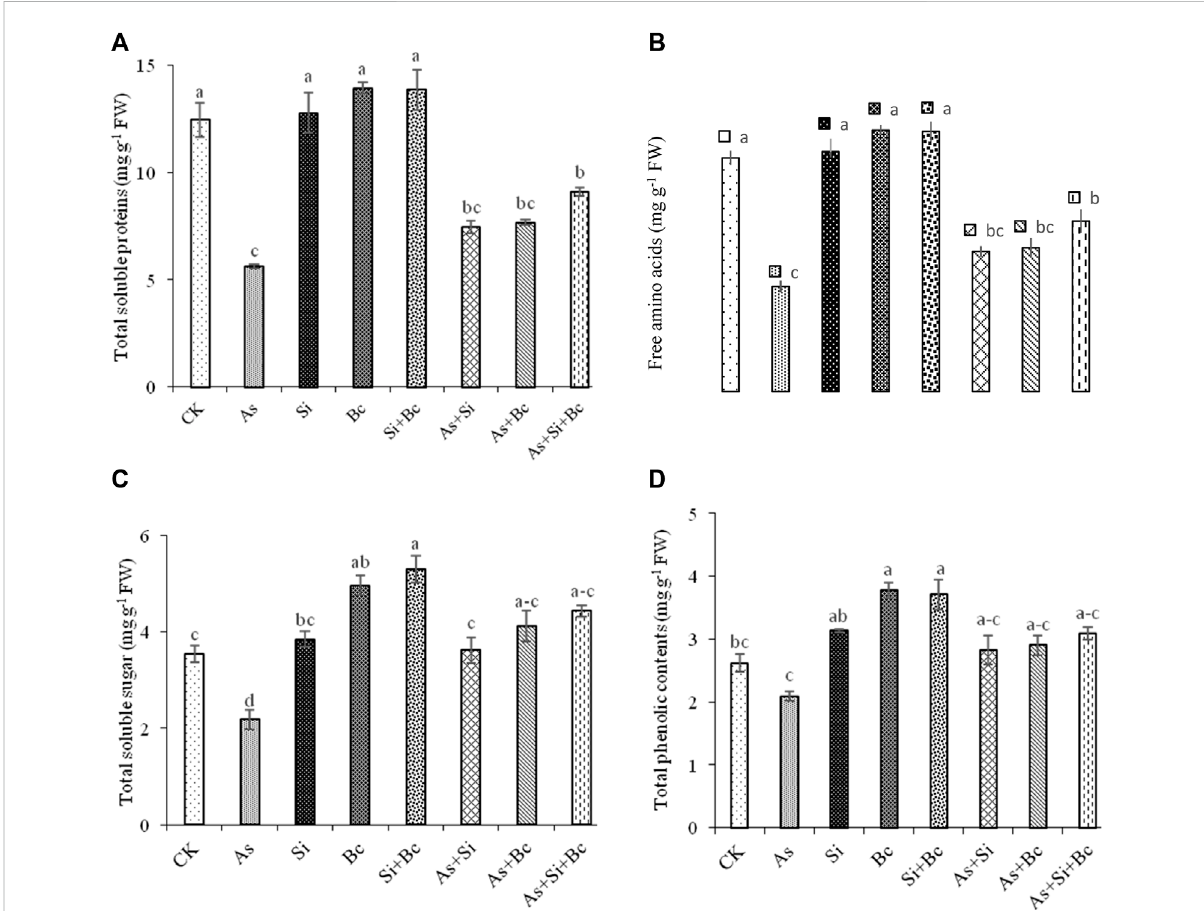
FIGURE 2 Effect of sole and combined applications of silicon and biochar on total soluble proteins (A) , free amino acids (B) , total soluble sugars (C) , and totalphenoliccontents (D) ofmaizeunder Astoxicity. Barssharing thesame letterdo nothave asigni fi cant( p < 0.05)difference.Error barsshow the standard error of